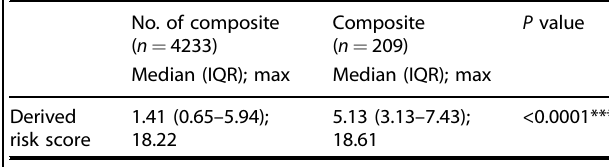
Table 7. Derived score characteristics of patients with/without composite outcome.